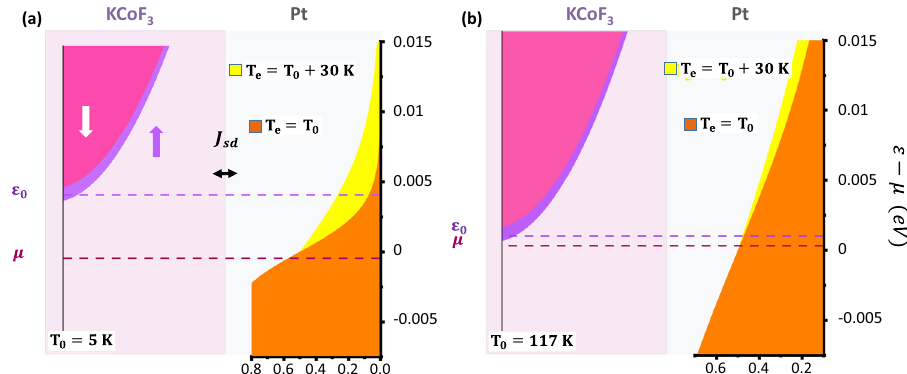
Fig. 4 | Spin pumping across the AFI – Pt interface. a At T ≪ T N , the gap in the magnon DOS fully opens subtracting the contribution of low energy magnons to the spinpumping. Increasing the laser fl uenceresults in a highereffective electron temperatureinPtandhigherenergymagnonsstarttocontributetospinpumping. In the above graph we show the speci fi c case of KCoF 3 . The Fermi – Dirac